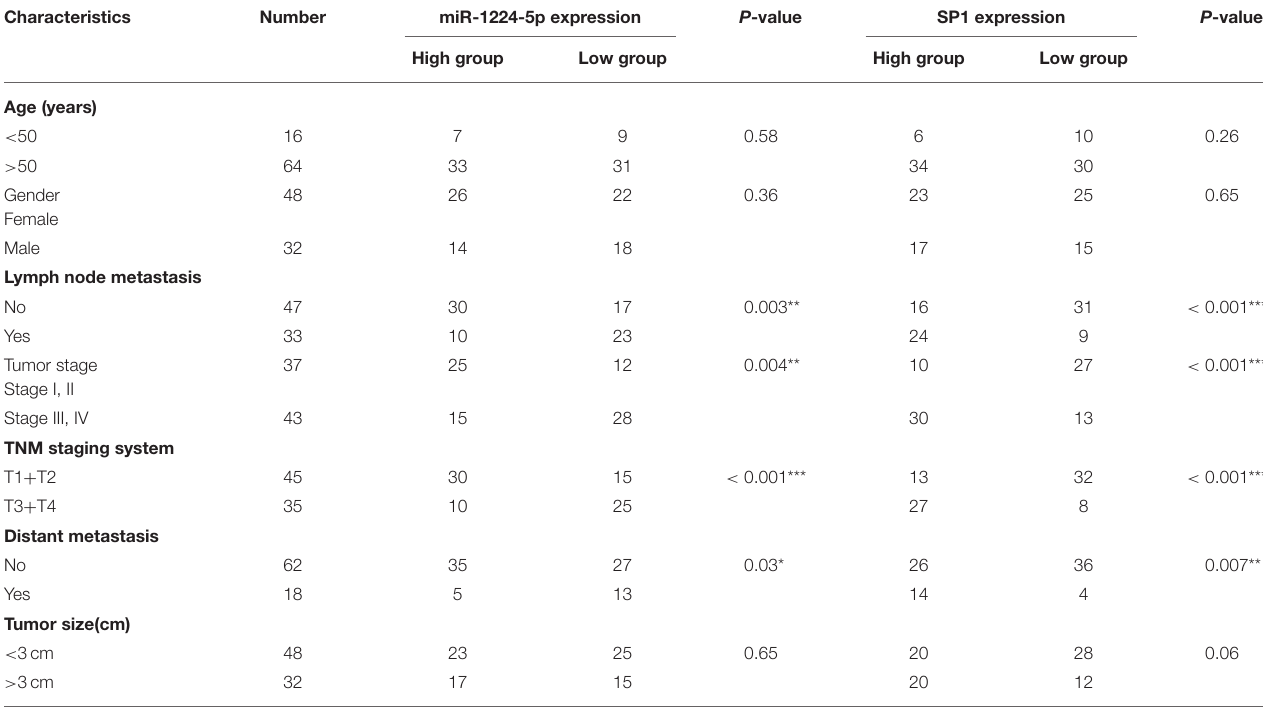
TABLE 1 | Expression of miR-1224-5p and SP1 according to patients’ clinical features. Characteristics Number miR-1224-5p